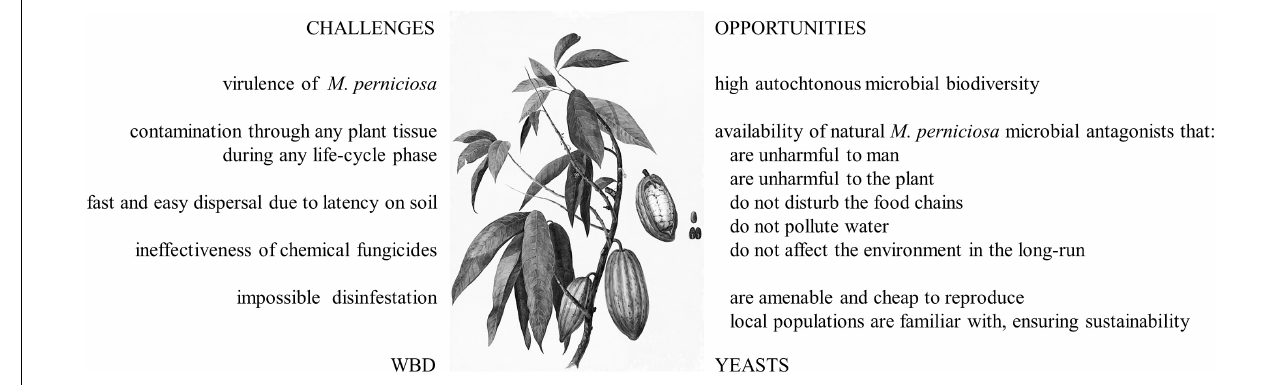
FIGURE 1 | Diagram presenting the challenges posed by WBD and the opportunities that natural antagonistic yeasts present for the containment of the disease. Cacao plant figure adapted from Panhuys, L. von, Watercolours of Surinam (1811–1824) (source: (CC) BY-NC-ND http://plantillustrations.